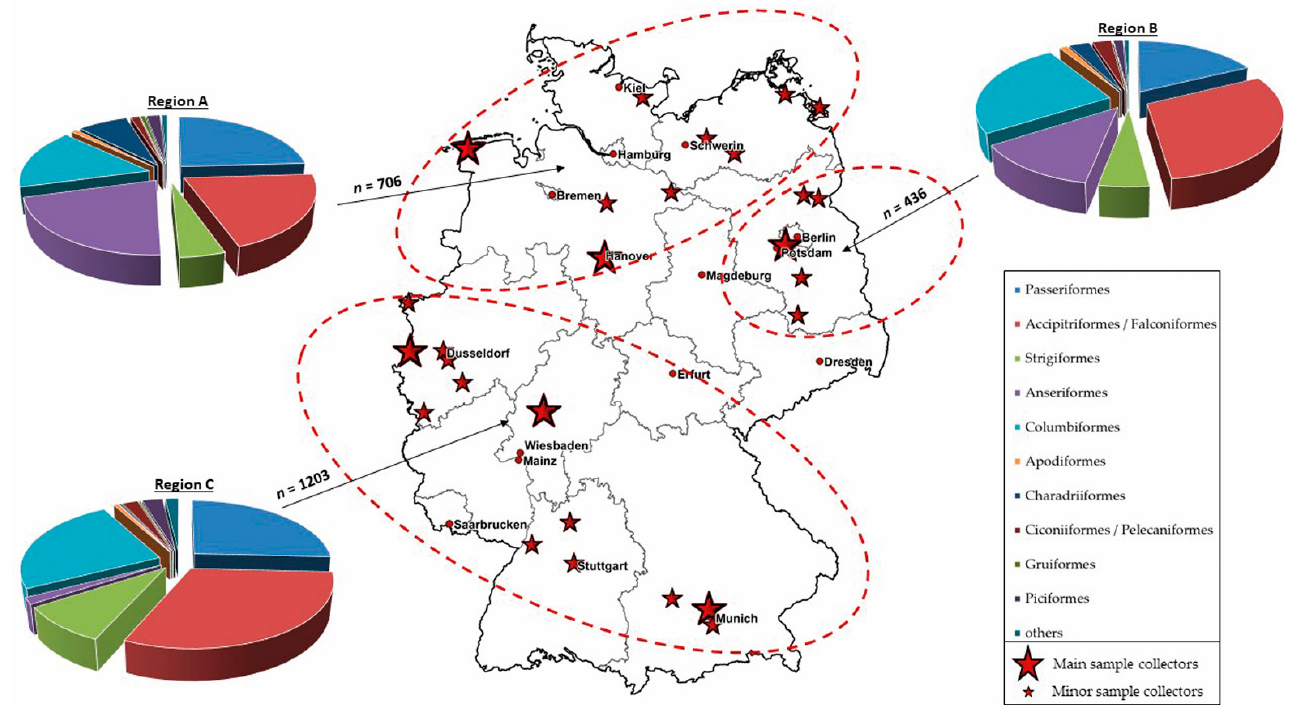
Figure 1. Total number ( n ) of blood samples collected in 2019 and 2020 and sampled bird orders per sampling region A to C. Region A: northern and central-western part of Germany; region B: eastern and central-eastern part of Germany; region C: central and southern parts of Germany (ellipses). The main sample collectors (big red stars) and the minor sample collectors (small red stars) of the wild bird network are shown for each region.